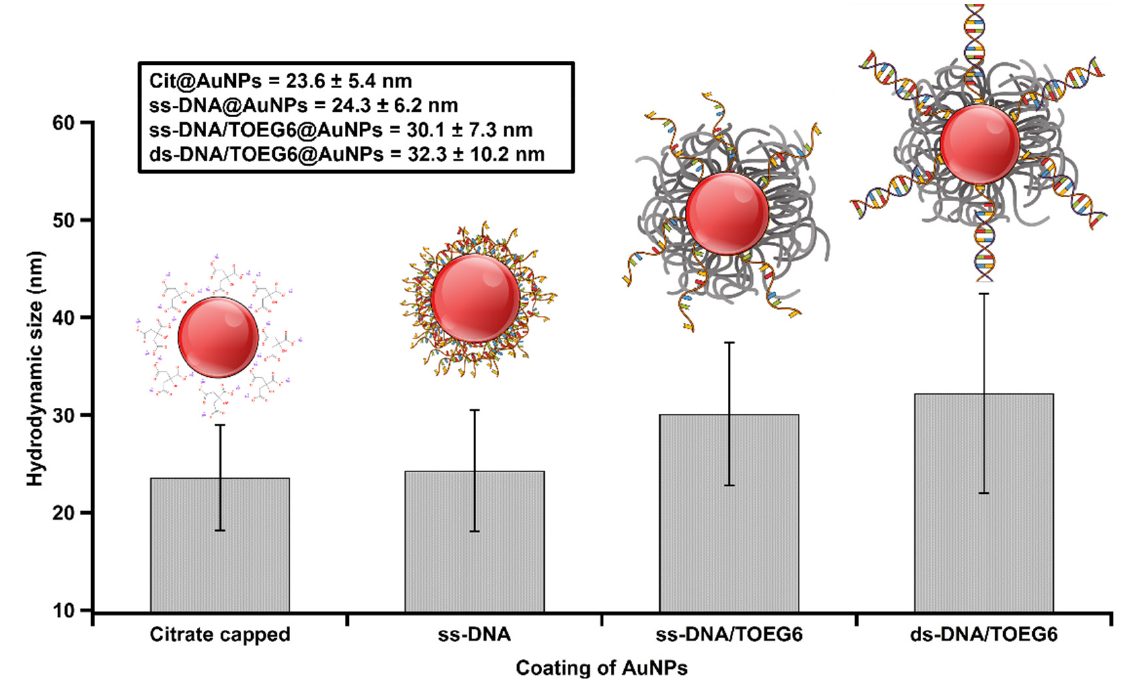
Figure 4. Summary of volume-weighted DLS measurements after each step of functionalization. The corresponding cartoons illustrate possible configurations of oligos adsorbed on the AuNP surface.